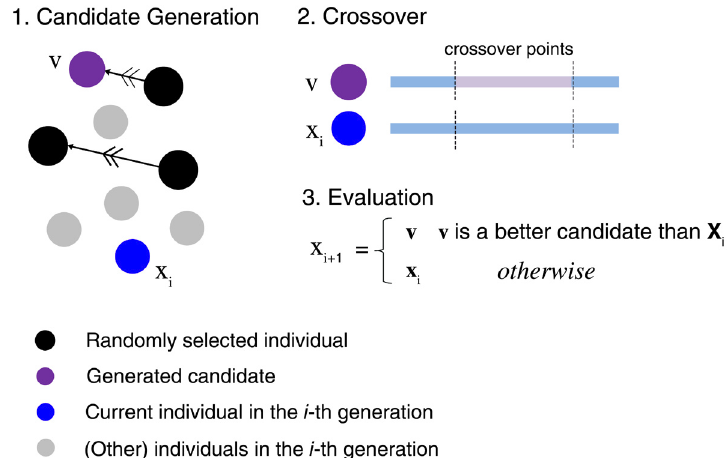
Figure 2. Evolutionary algorithm. The steps involved in evolutionary optimization are outlined. First, a candidate v is obtained from three randomly selected individuals by a differential operation. Second, a crossover operation is applied to an individual x Third, the evaluation step involves ε level comparison of v and x